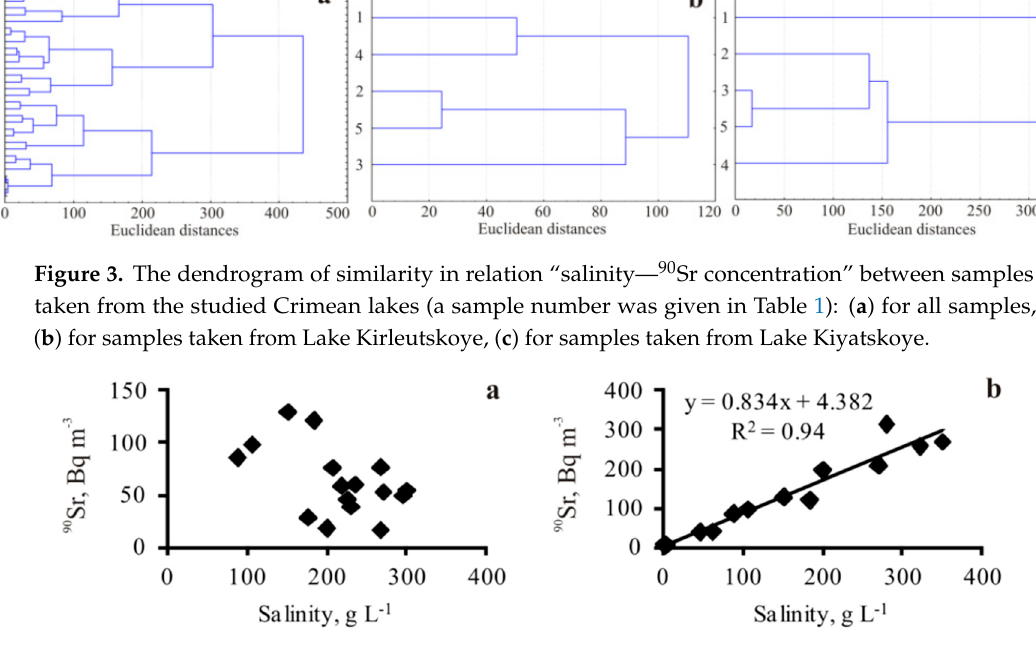
Figure 4. The correlation between salinity and 90 Sr concentration in the first ( a ) and second ( b ) cluster of the studied lakes.